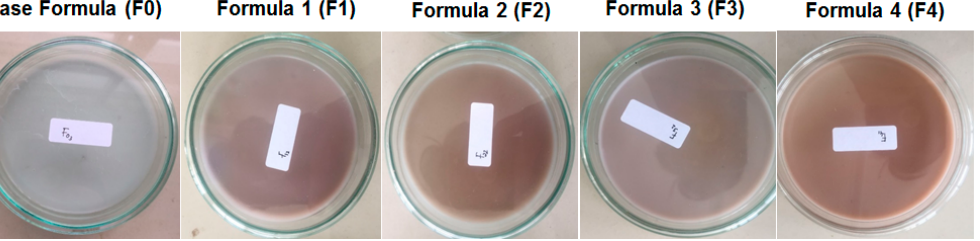
Figure 6. Organoleptic properties of polyvinyl alcohol/cornstarch/patchouli oil/hydrogel films loaded with silver nanoparticles.